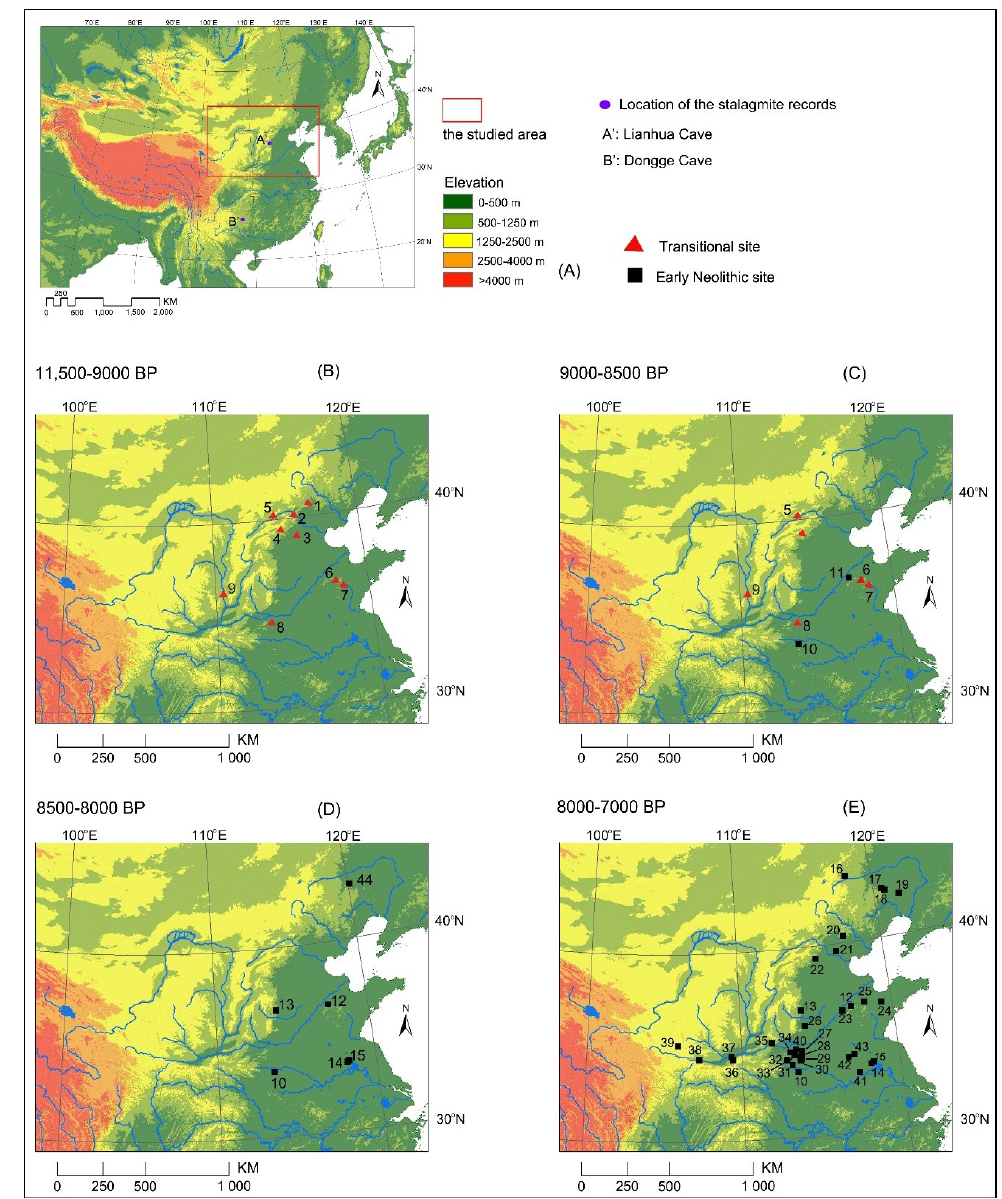
Figure 1. The distributions of the archaeological sites from 11,500 to 7000 cal BP. ( A ). Studied area; ( B ). The distributions of the archaeological sites from 11,500 to 9000 cal BP; ( C ). The distributions of the archaeological sites from 9000 to 8500 cal BP; ( D ). The distributions of the archaeological sites from 8500 to 8000 cal BP; ( E ). The distributions of the archaeological sites from 8000 to 7000 cal